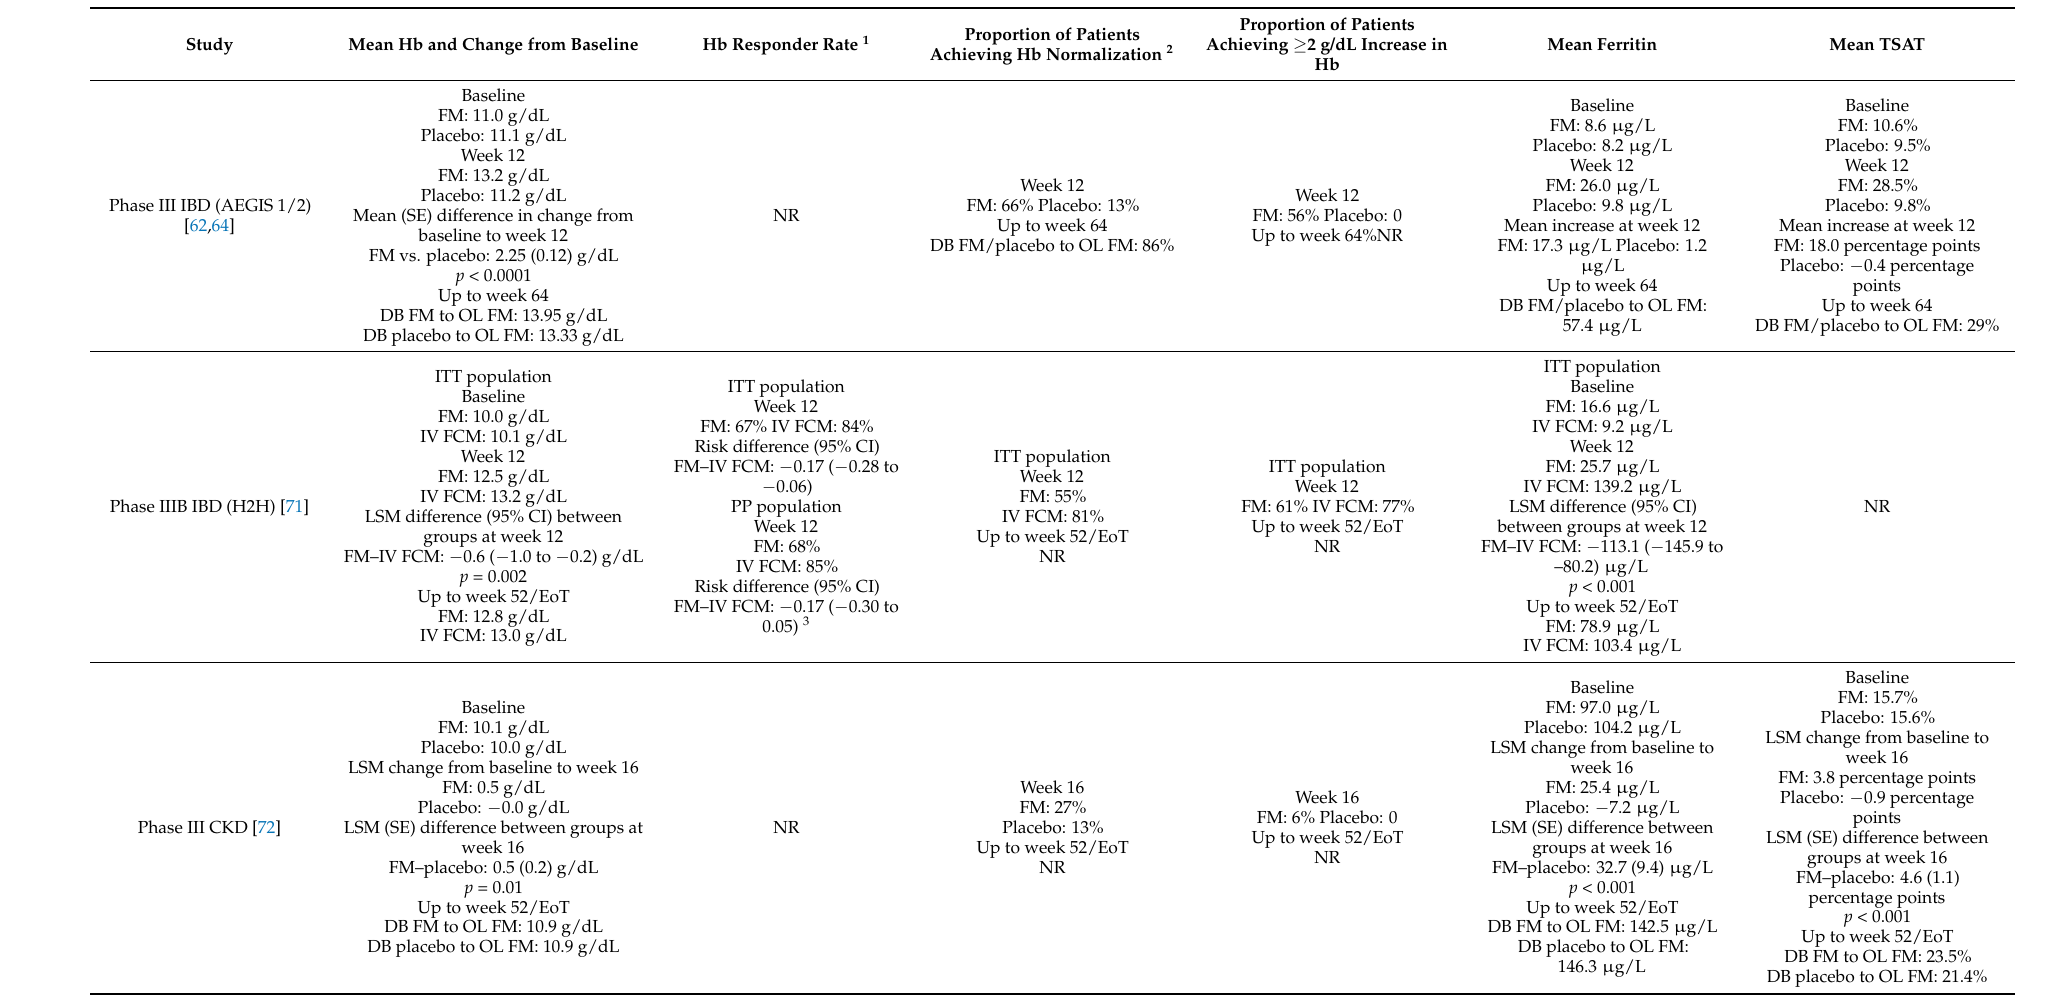
Table 2. Phase III studies of ferric maltol in adults: key efficacy